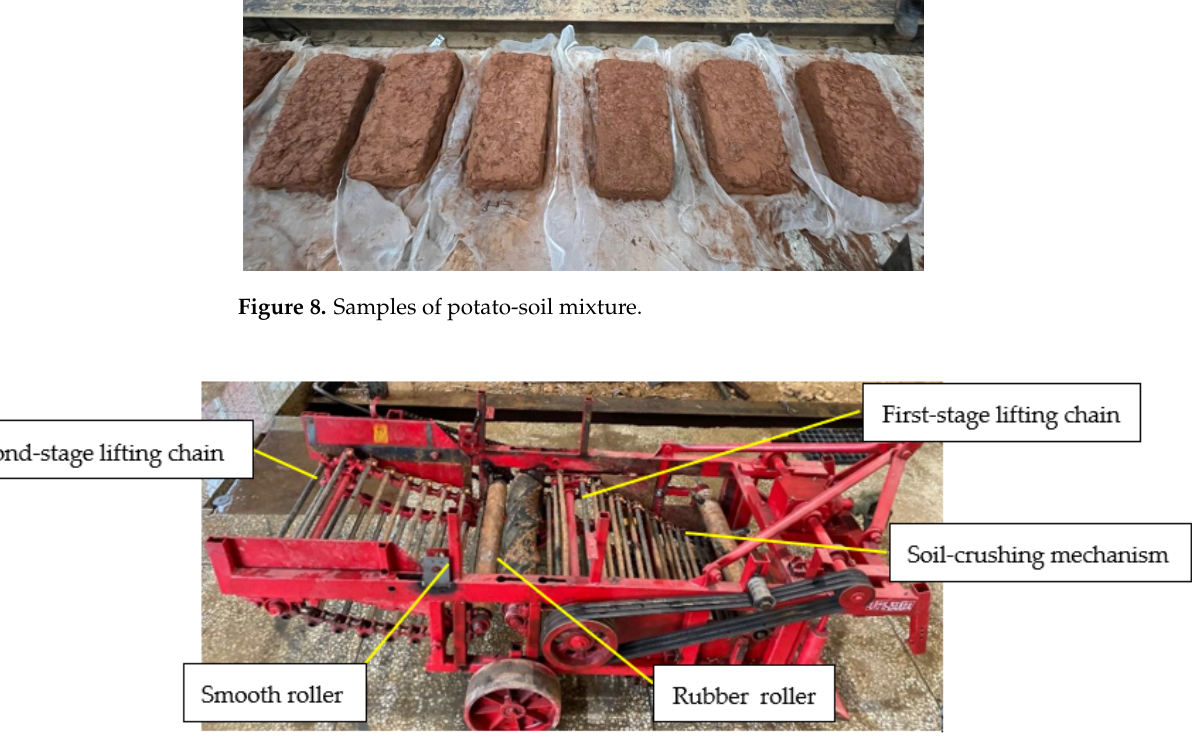
Table 1. Masses of the individual constituents of samples with different initial moisture contents.